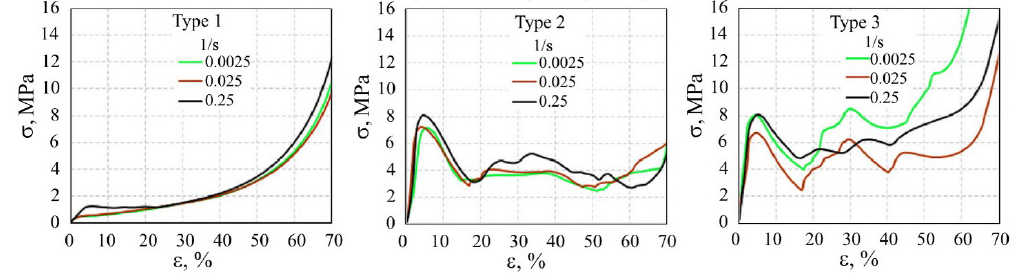
Figure 3: Stress-strain curves of unreinforced (type 1), transverse reinforced (type 2), and longitudinal reinforced (type 3) foam samples for different strain